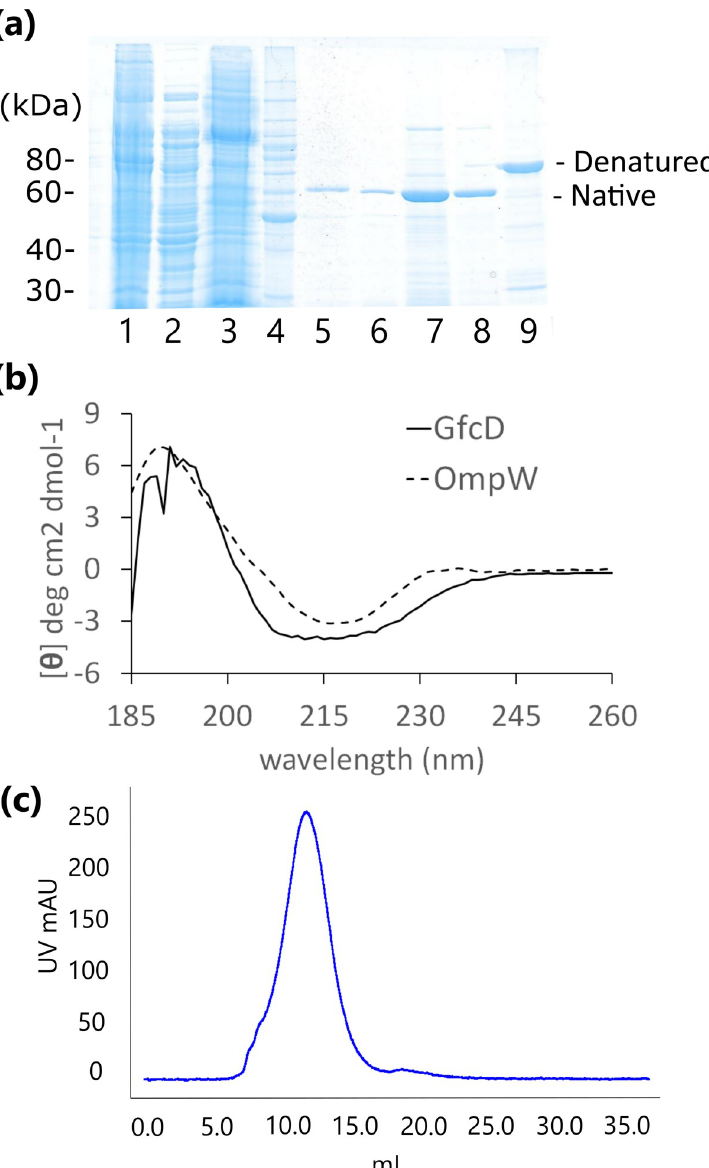
Fig 2. Purification of GfcD. (a) SDS-PAGE gel showing the purification of GfcD, encoded from pBH31 vector. The lysates (lane 1) were separated by ultracentrifugation into soluble (lane 2) and membrane (lane 3) fractions. Lane 4 is the molecular weight ladder (Invitrogen Benchmark). After solubilizing GfcD with 5% Elugent, it was affinity purified on TALON (lane 5). His-tag was removed by TEV cleavage (lane 6), and then GfcD was purified by ionic exchange (lane 7) followed by size exclusion purification (lane 8). Boiling the sample results in a migration shift (native vs. denatured) common to β -barrel proteins upon unfolding (lane 9). (b) Circular dichroism spectra of GfcD protein compared against the known β -barrel protein OmpW. (c) The GfcD protein was exchanged into a buffer of 20mM Hepes pH 7, 150mM NaCl, 0.02% DDM over a Superdex 200 10/300 size exclusion column and demonstrated a symmetrical